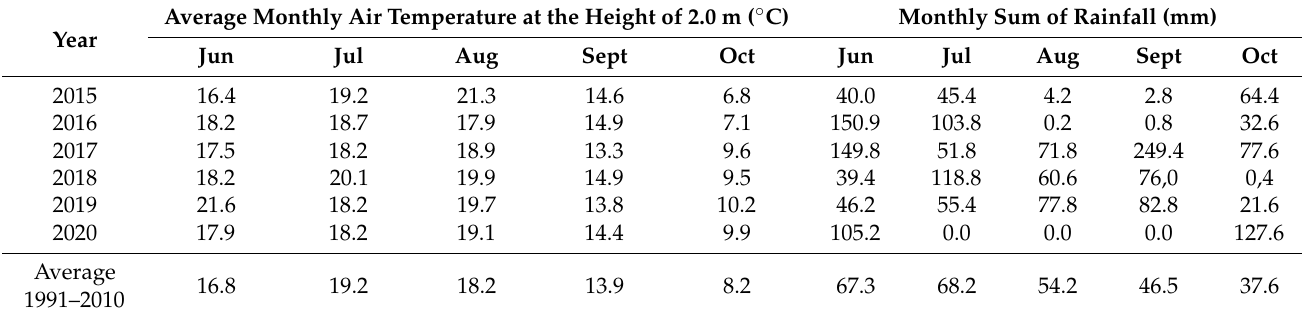
Table 1. Climatic conditions in Skierniewice in the period